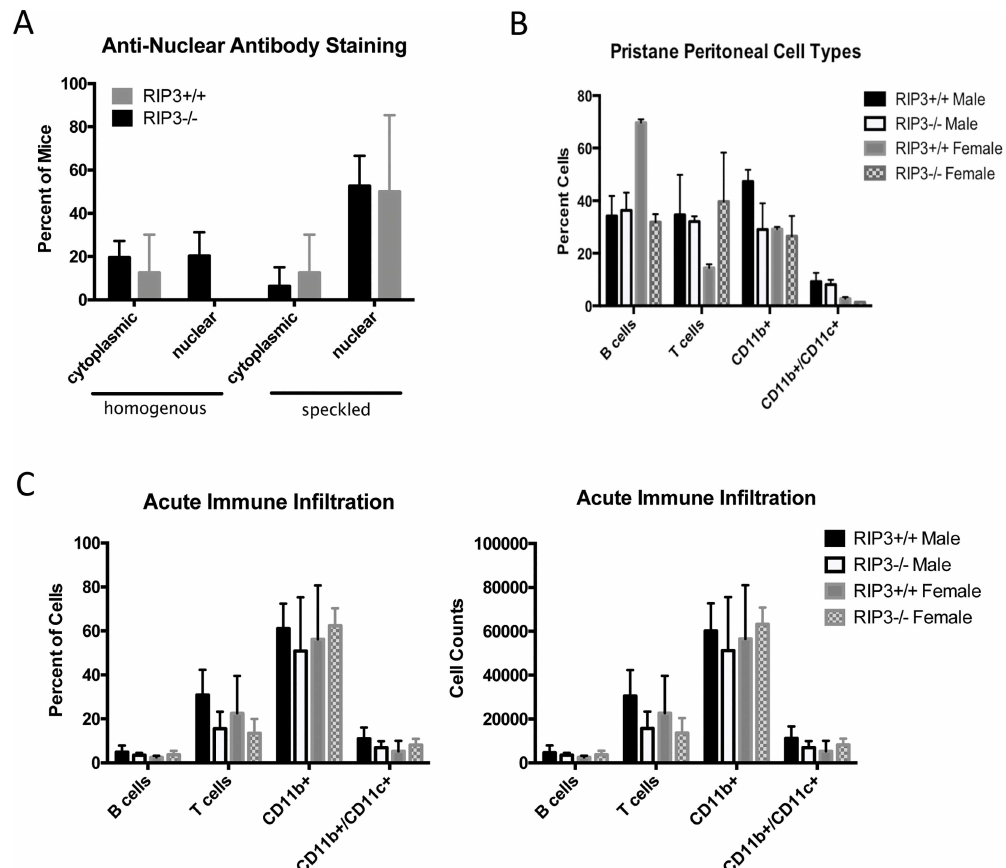
Fig 2. Pristane-induced systemicautoimmunity is not dependent on RIPK3. (A) Pristane treatment induced similar ANA patterns between WT and RIPK3-/- mice. Experiments were performed with 14 mice per strain, p > 0.05 using Chi Square analysis. (B) After 6 months and (C) after 2 weeks from pristane injection, peritoneal immune cell infiltrates were characterizedby flow cytometry. There were similar percentages of B cells, T cells, CD11b+monocytes, and CD11b+/CD11c+ conventional dendritic cells (cDCs) present in the peritoneal cavity during pristine-induced systemic autoimmunity. 5 mice per strain were used for the acute, 14 mice per strain were used for the chronic (6 month) experiments. Data are representedby ± SEM and population differences (p > 0.05) measured using Ttest.